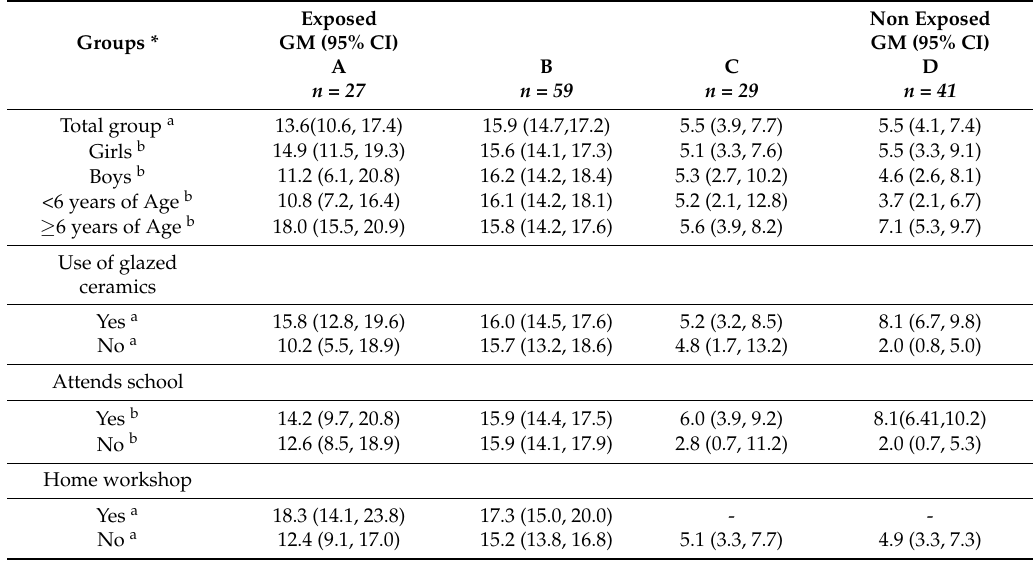
Table 2. Average blood lead concentration ( µ g/dL) of exposed and non-exposed child communities to mining waste sites, Taxco, Guerrero, Mexico,